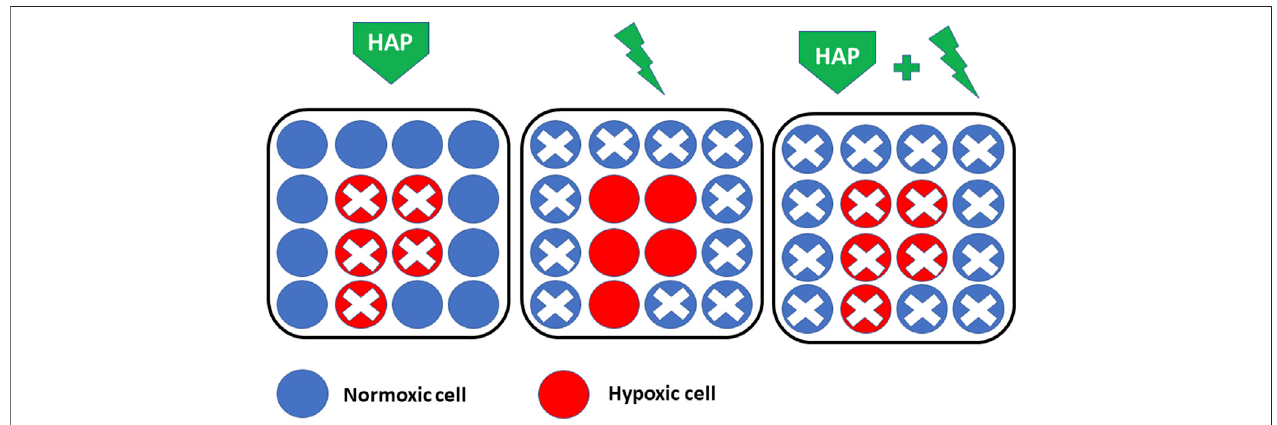
FIGURE5| Rationaleforcombining HAP(hypoxia-activatedprodrugs)withradiationtherapy. HAPsareselectivelykillinghypoxiccells(Left) whileradiationtherapy is ef fi cient in killing non-hypoxic cells (Middle). There is a major interest for combining both approaches for a maximal response (Right).